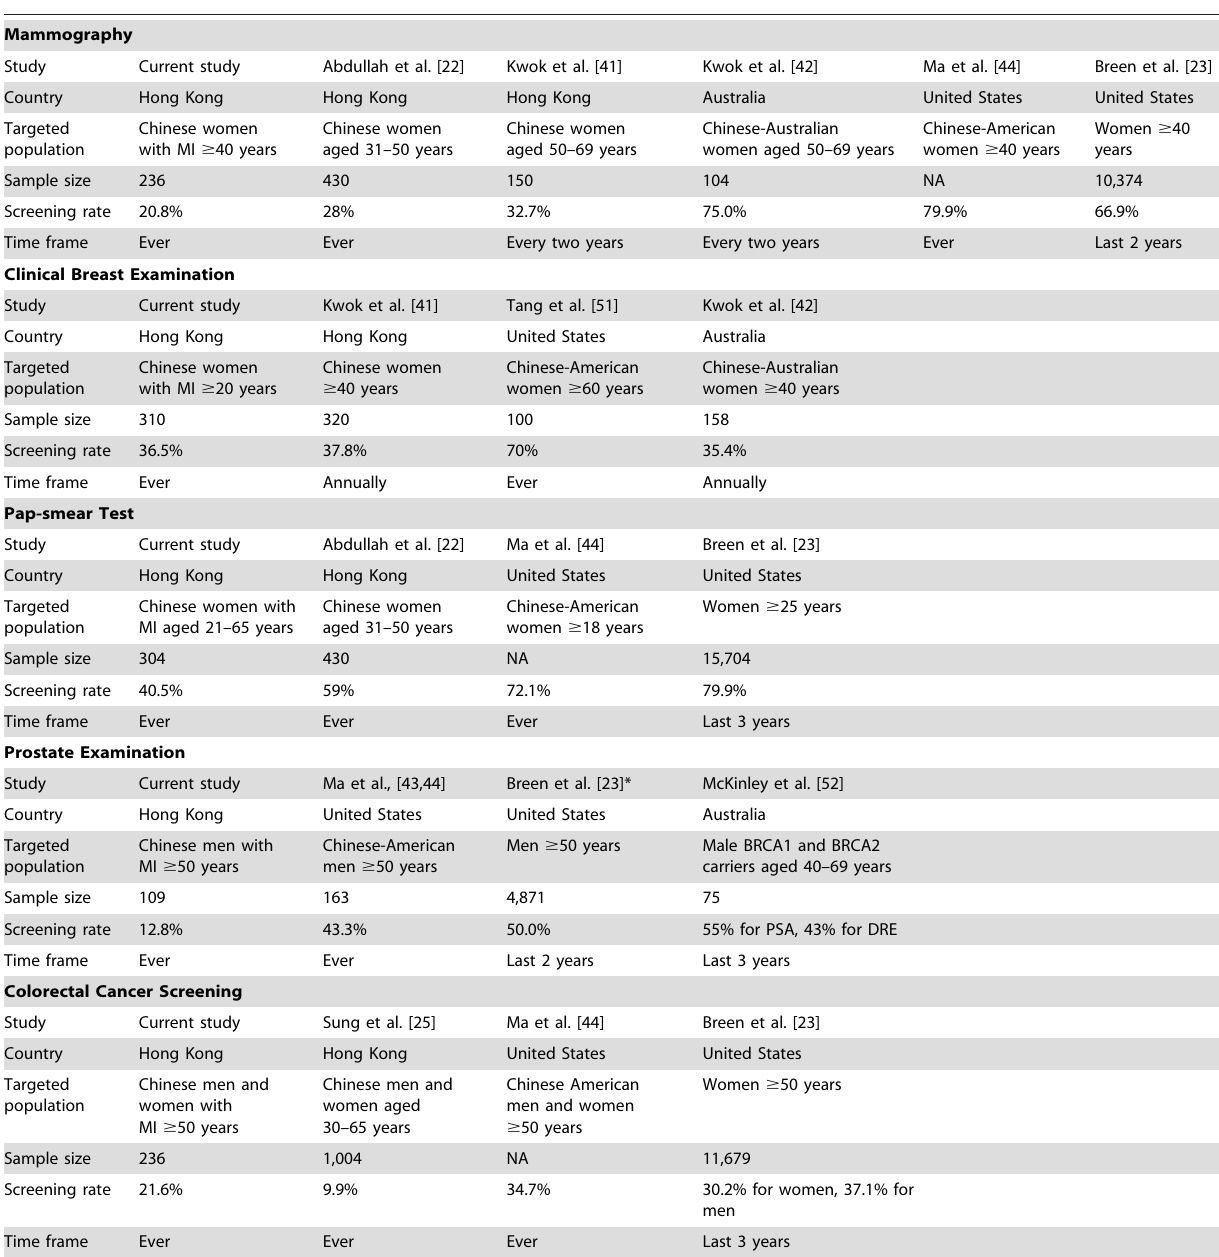
Table 3. Cancer Screening Behavior Reported in Other